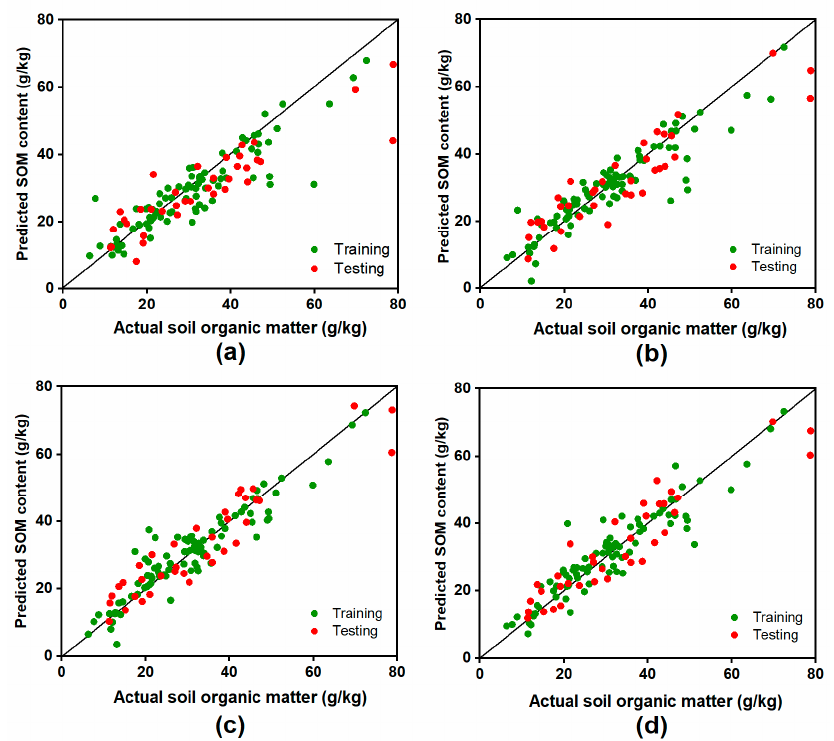
Figure 9. The prediction plots of SOM content by the PLSR model established by LDA after dividing the range of SOM content into ( a ) 5 categories, ( b ) 7 categories, ( c ) 9 categories, ( d ) 11 categories.